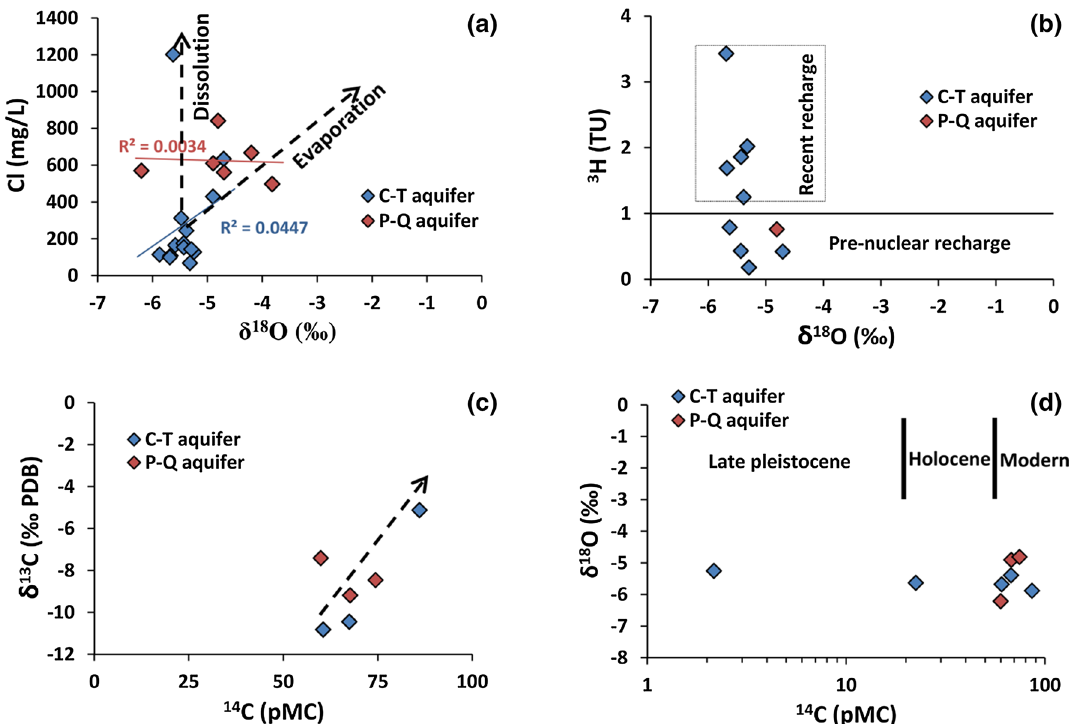
Fig. 11 a δ 18 O versus Cl diagram, b δ 18 O versus 3 H, c δ 13 C versus 14 C, d δ 18 O versus 14 C. C-T = Cenomanian-Turonian, P-Q =